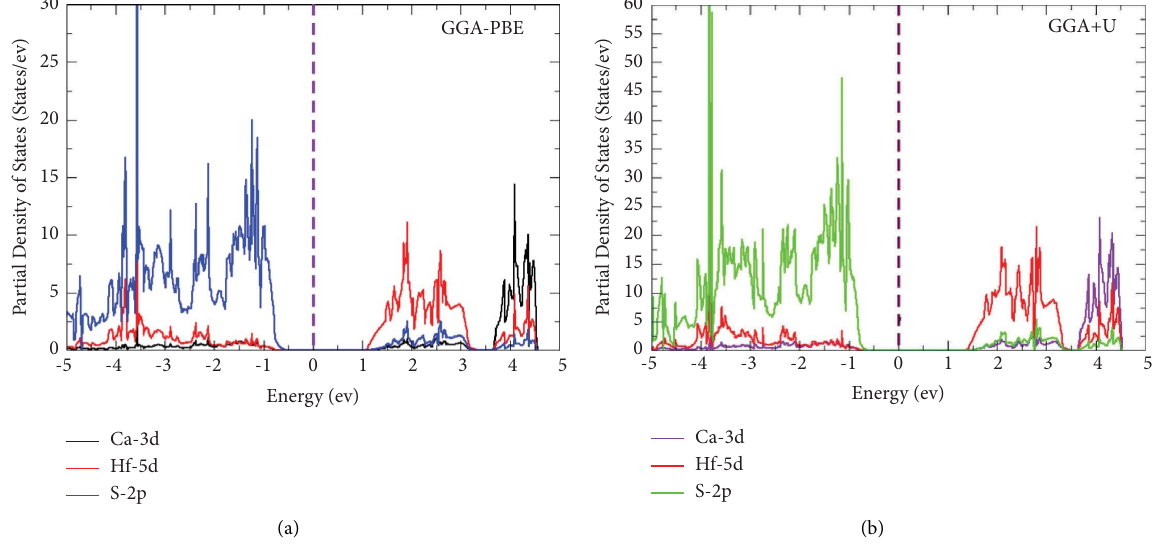
Figure 4: Te partial density of states of CaHfS 3. with respect to GGA-PBE (a) and GGA +U